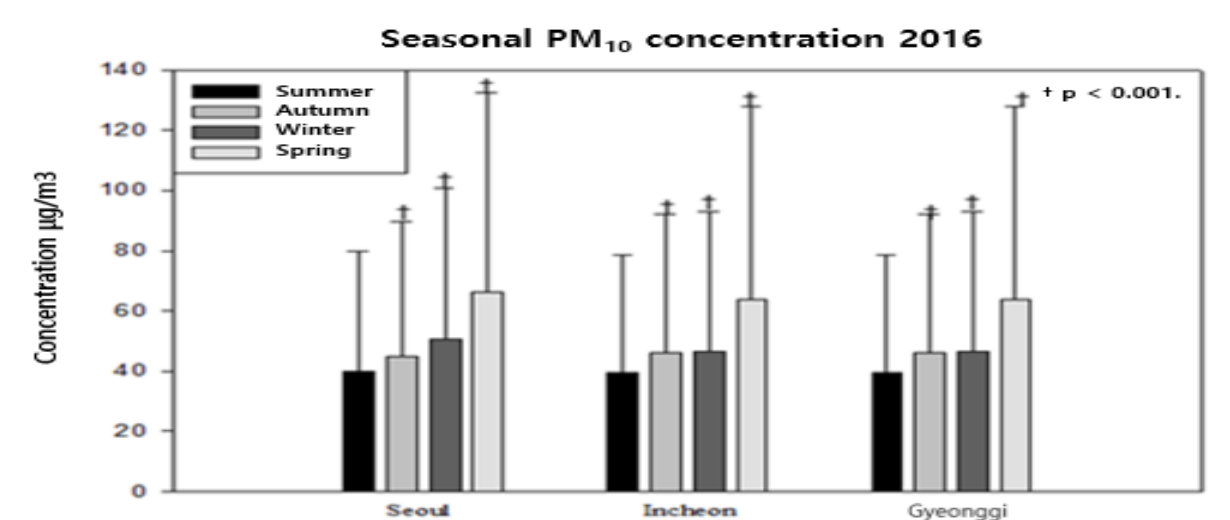
Figure 1. Correlation between the concentration (log-linear) of seasonal fine dust (PM10 and PM2.5) and the Seoul area (2015).